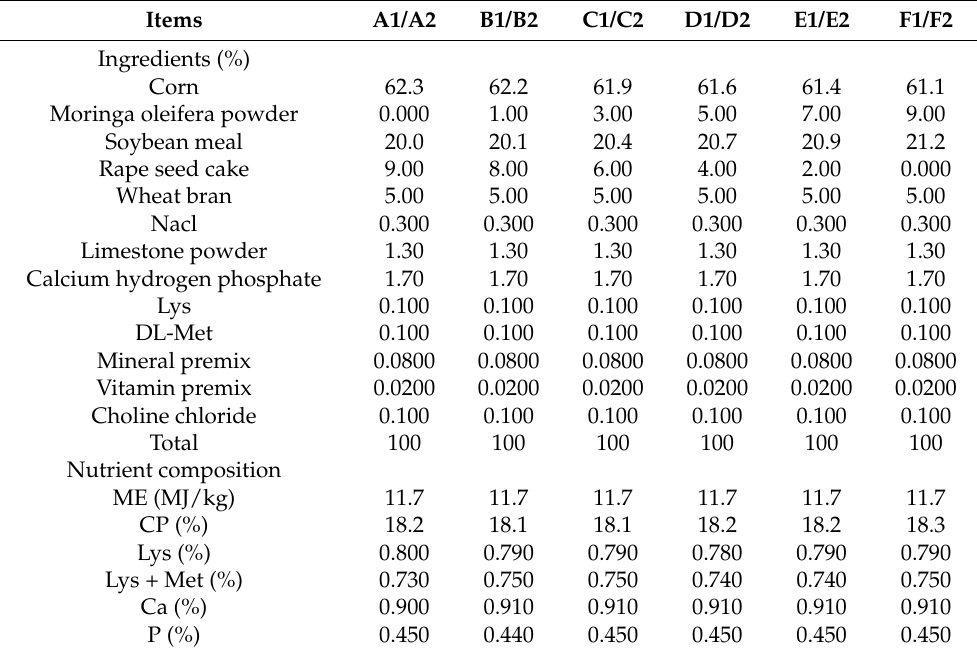
Table 1. Ingredient and nutrient composition of the experimental